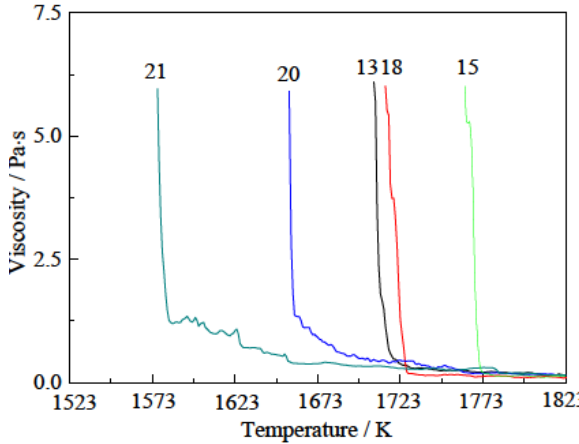
Figure 6: Viscosity curves of La 2 O 3 -SiO 2 -FeO-Al 2 O 3 -MnO and La 2 O 3 - SiO 2 -FeO-Al 2 O 3 -B 2 O 3